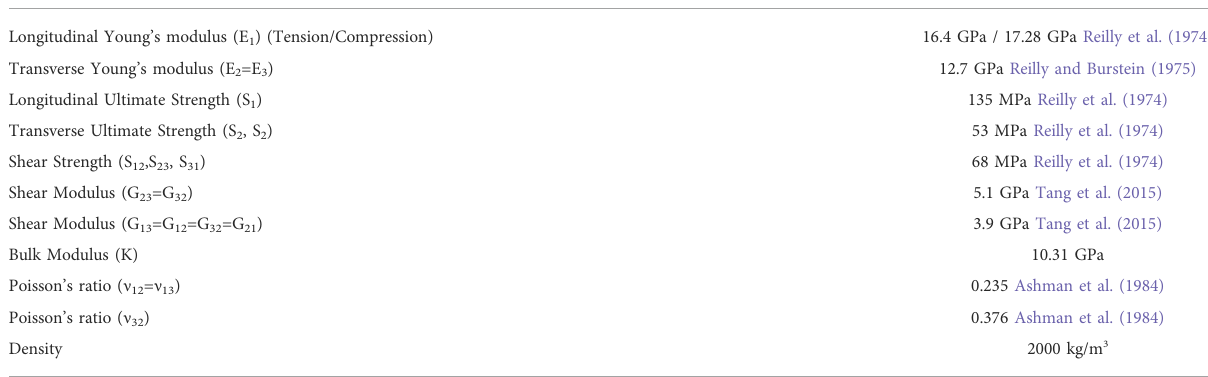
TABLE 1 Cortical bone material property summary (Khor et al.,